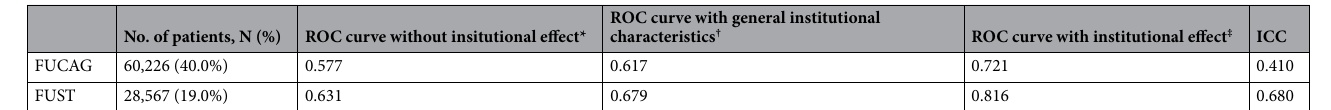
Table 4. Importance of institutional factors in the variation of follow-up strategies. *Logistic regression models including patient characteristics as covariates. † Logistic regression models including patient characteristics and hospital characteristics as covariates. ‡ Hierarchical logistic regression models including patient characteristics and hospital random effects. FUCAG follow-up invasive coronary angiography, FUST follow-up stress testing, ICC intraclass correlation coefficient, ROC receiver operating characteristic.